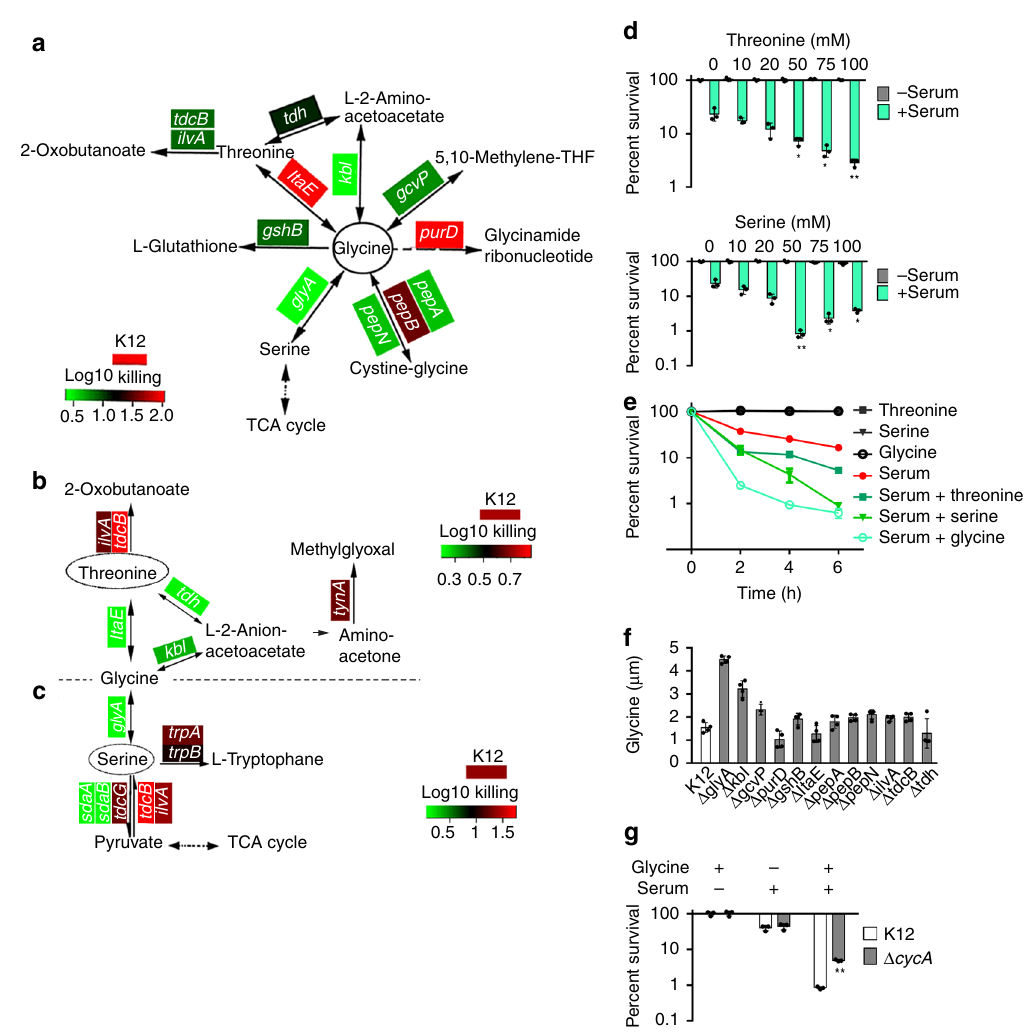
Fig. 4 Glycine fl ux to the TCA cycle regulates bacterial serum susceptibility. a – c Survival of the E. coli mutants in the presence or absence of 100 µ L serum plus 100 mM glycine ( a ), threonine ( b ) or serine ( c ). Heat map scale (blue to red) represents low to high killing without the indicated gene ( n = 3). d Percent survival of E. coli K12 incubated with or without 100 μ L serum plus different concentrations of serine (0 – 100 mM) or threonine (0 – 100 mM) ( n = 3). e Percent survival of E. coli K12 incubated with 100 μ L serum plus 50 mM glycine, serine, or threonine for different time points ( n = 3). f Glycine level of the E. coli mutants as the same as ( a ) ( n = 4). g Percent survival of E. coli K12 and Δ cycA in the presence of 100 μ L serum, 100 mM glycine or both ( n = 3). Results are displayed as mean ± SEM ( d – g ), and signi fi cant differences are identi fi ed (* p < 0.05, ** p < 0.01) as determined by two-tailed Student ’ s t test ( d , f , g ). See also Supplementary Fig.